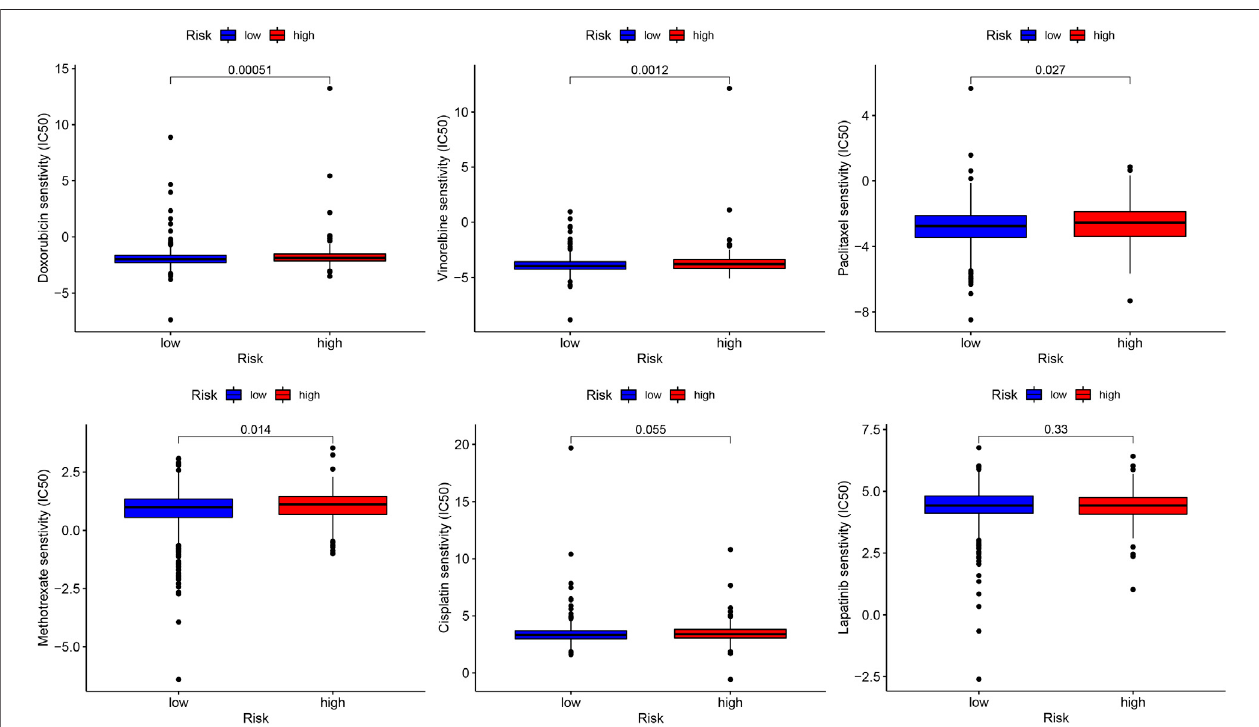
FIGURE 7 | Role of the YTHDF3-based nomogram in predicting the sensitivity to therapeutic drugs. The box plots display the estimated IC50 of vinorelbine, cisplatin, doxorubicin, methotrexate, paclitaxel, and lapatinib.